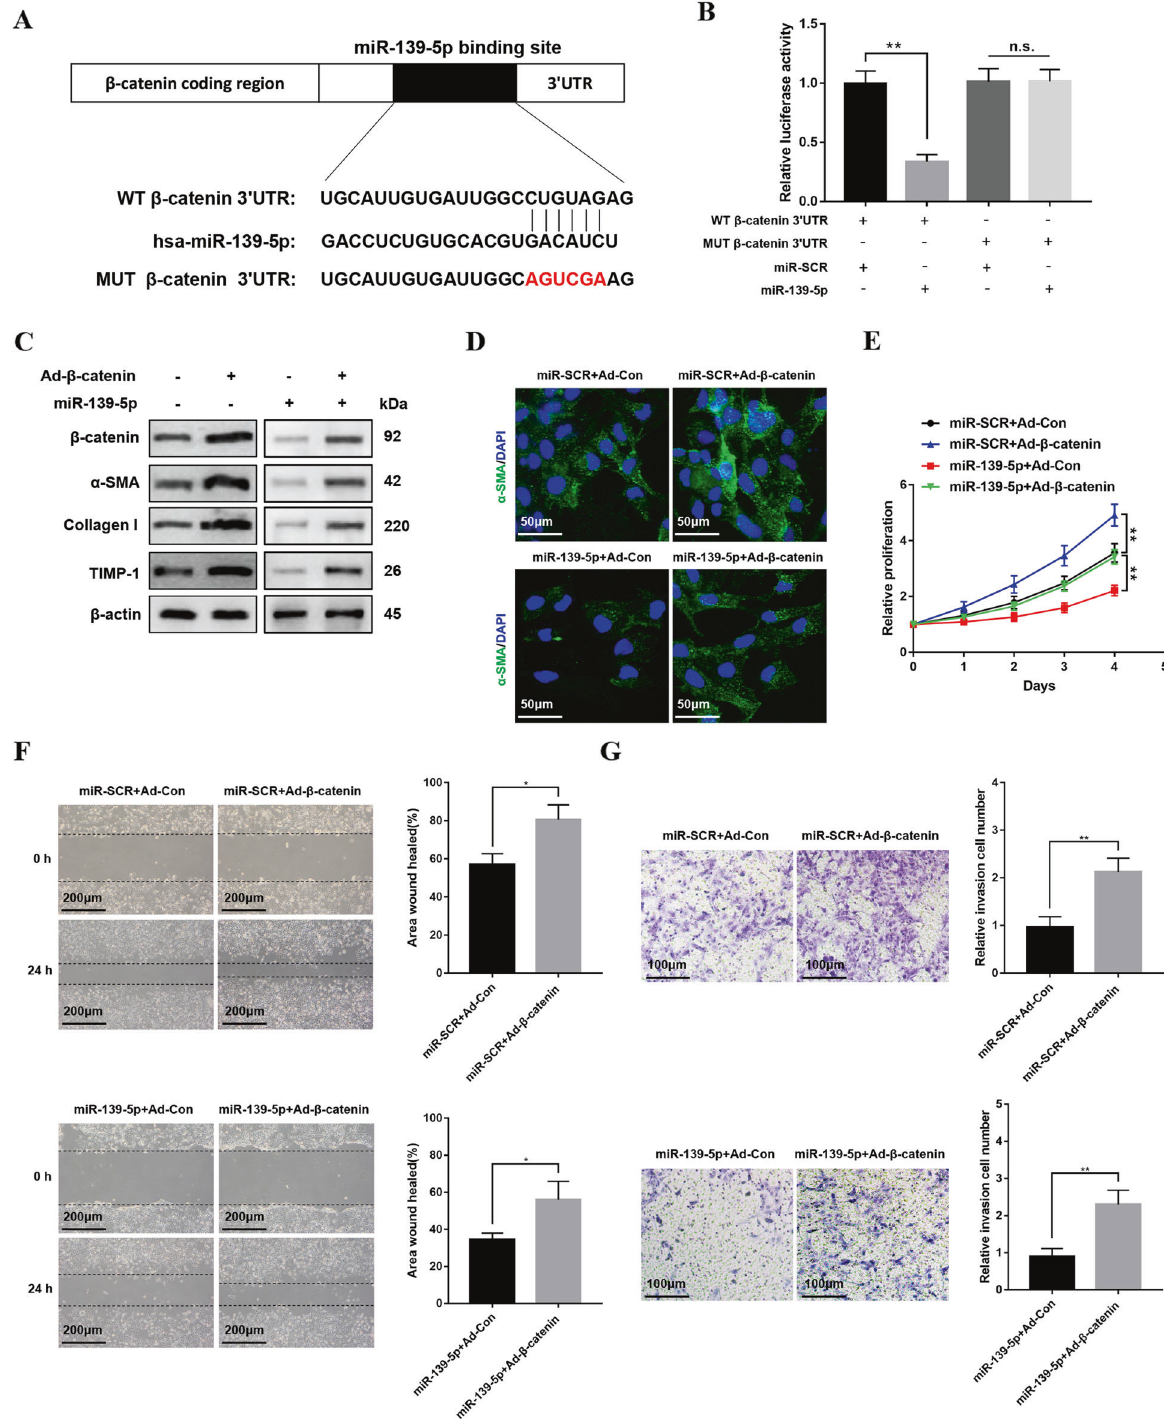
Fig. 4 miR-139-5p regulates the expression of β -catenin by binding to the 3 ’ UTR of its mRNA directly. A schematic diagram suggested the putative binding sites of miR-139-5p with respect to β -catenin. B WT HLF 3 ’ UTR or MUT HLF 3 ’ UTR luciferase reporter activity in LX-2 cells was detected by dual-luciferase reporter assay. C The protein levels of β -catenin, α -SMA, Collagen-I, and TIMP-1 in LX-2-pre-miR-139-5p cells infected with Ad- β -catenin were detected by western blotting. Representative of three experiments. D Immuno fl uorescence staining for α - SMA (green) in LX-2-pre-miR-139-5p cells after transfection with Ad- β -catenin was observed by confocal laser microscopy. DAPI was used to stain nuclei, blue. Original magni fi cation×400, Representative of three experiments. E Proliferation of LX-2-pre-miR-139-5p cells infected with Ad- β -catenin was analyzed by CCK8 assay. F The wound-healing assay of LX-2-pre-miR-139-5p cells infected with Ad- β -catenin or Ad-Con was performed to analyze the migration capability. Representative of three experiments. G The transwell assay of the LX-2-pre-miR-139-5p cells transfected with Ad- β -catenin or Ad-Con was carried out to observe the migration capability, representative of three experiments. The number of cells was calculated from different fi elds. Graph represents mean ± SD. * P < 0.05, ** P < 0.01.